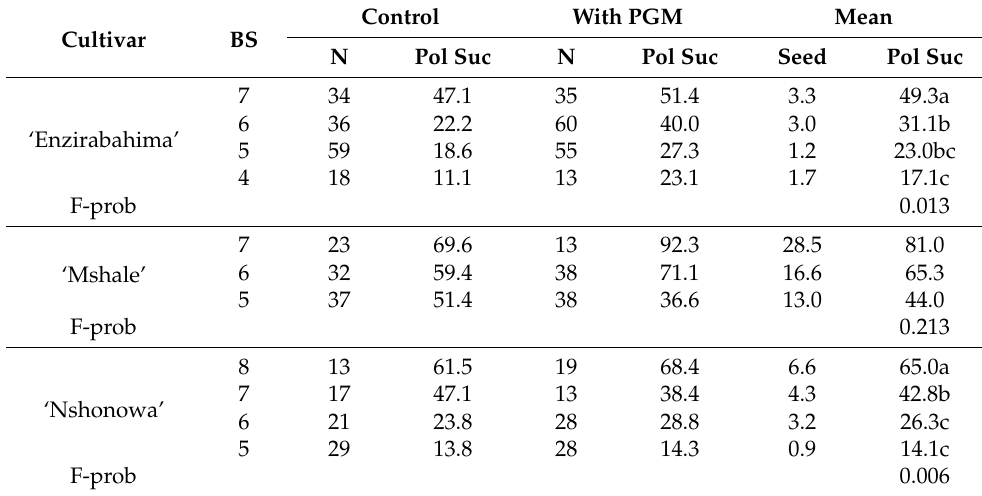
Table 4. Bunches pollinated, pollination success, and predicted mean seed per 100 fruits using two pollination techniques on East African Highland Cooking bananas. Control With PGM Cultivar BS